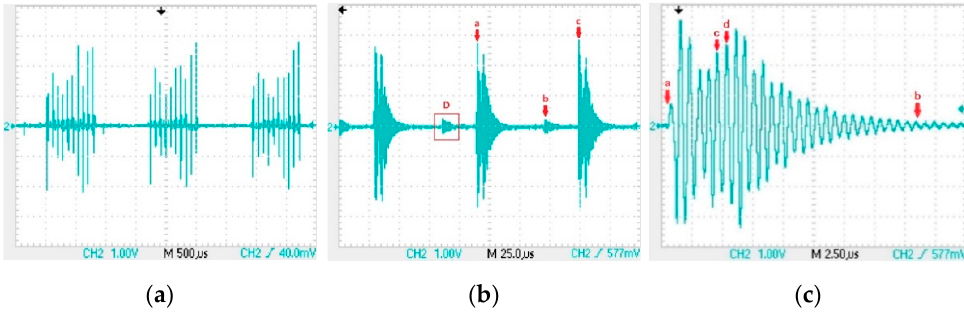
Figure 9. The waveform of the signal in the receiving coil: ( a ) signal waveform; ( b ) induced signal generated by continuous square wave in transmit coil; ( c ) oscillation signal generated by falling edge of square wave in transmitting coil.